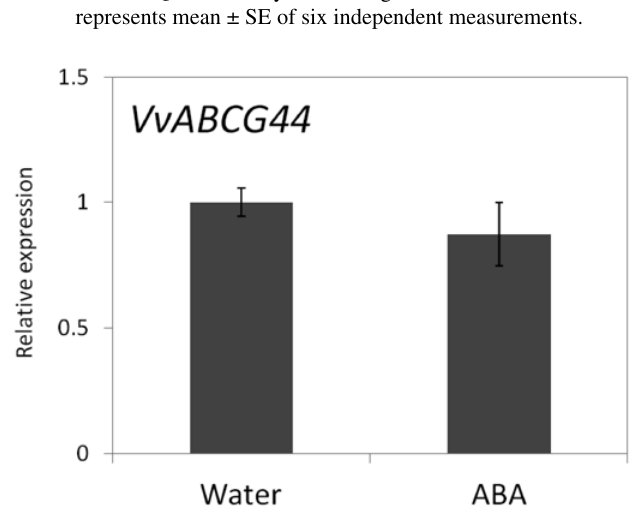
Fig. 5 - Expression of VvABCG44 in the grape berry skin after ABA treatment. mRNA level of VvABCG44 was detected by quan- titative PCR. Actin was used as an internal control. Each value represents mean ± SE of three independent